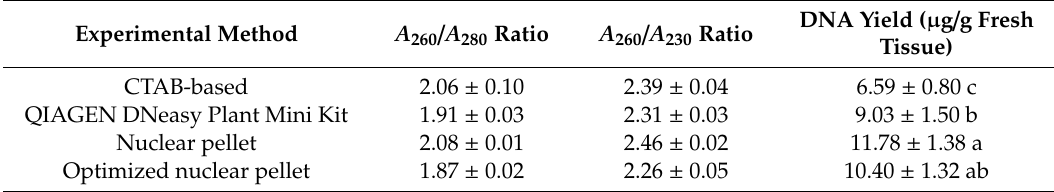
Table 1. Comparison of the genomic DNA absorbance and yield of rice ( Oryza sativa L.) tissue in the four di ff erent isolation